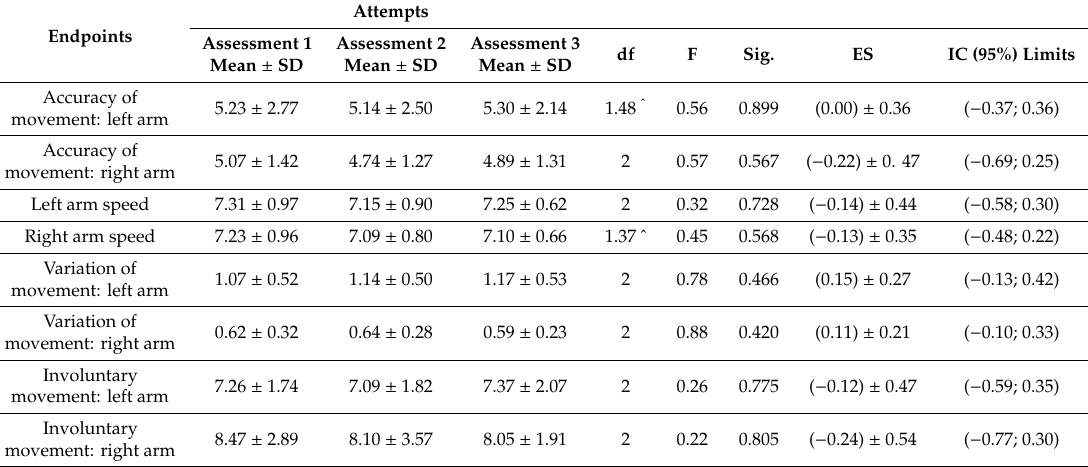
Table 3. The average di ff erence between attempts—upper limbs.